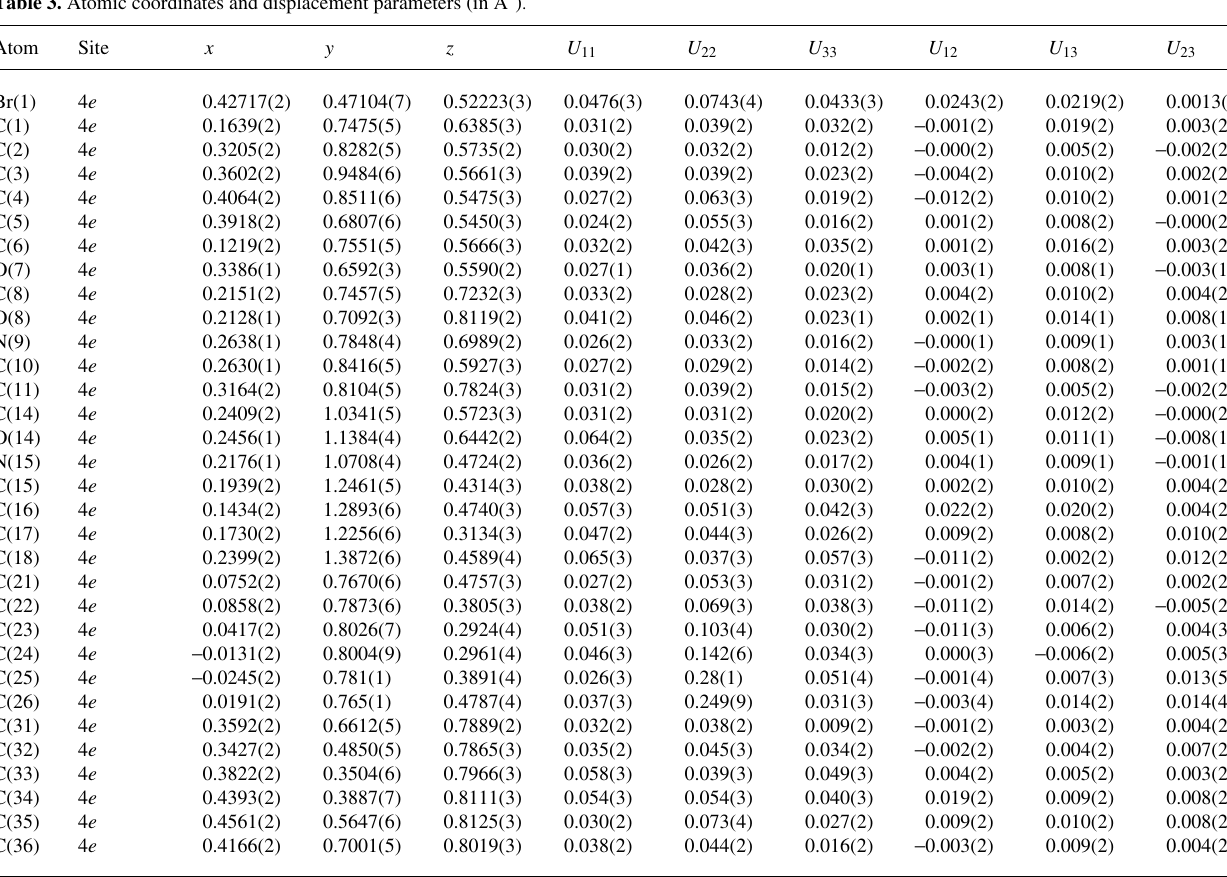
Table 3. Atomic coordinates and displacement parameters (in Å 2 ) .